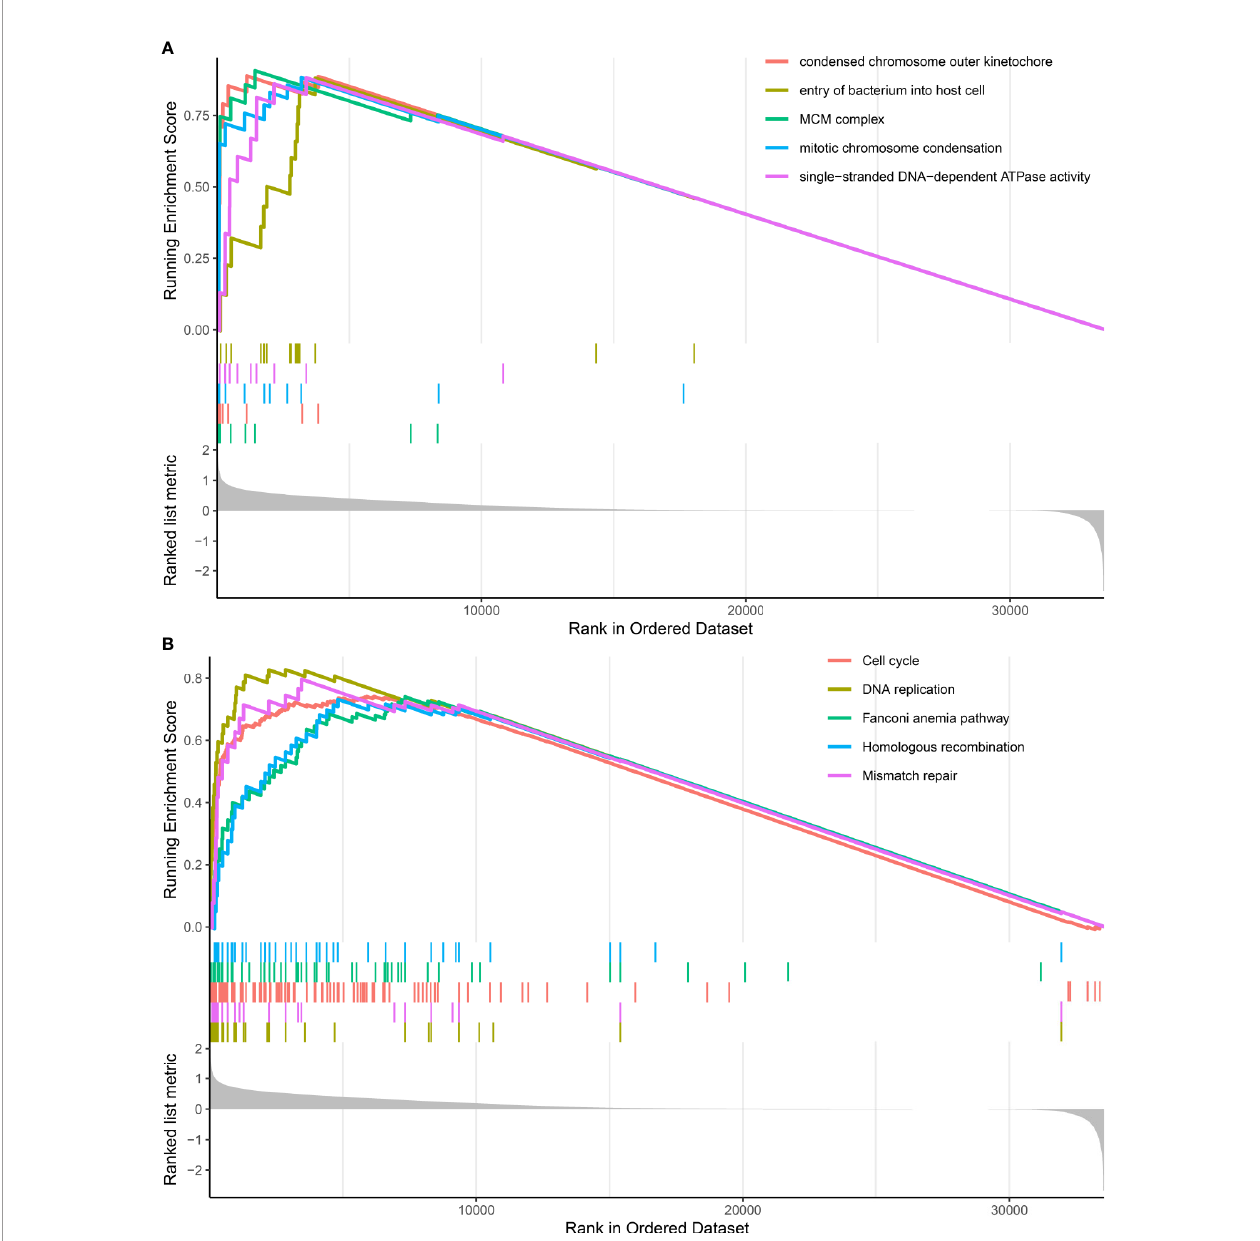
FIGURE 3 | Gene set enrichment analysis of DDR-subtype speci fi c pathway analysis. (A) Top fi ve most signi fi cant altered gene ontology terms in the DDR-activated subgroup when compared with the DDR-suppressed subgroup. (B) Top fi ve most signi fi cant altered KEGG pathways in the DDR-activated subgroup when compared with the DDR-suppressed